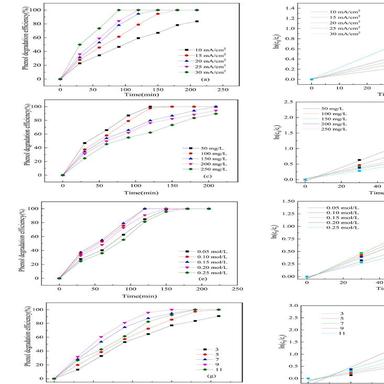
and d) presented the effect of different phenol concentrations (50, 100, 150, 200, 250 mg L− 1 ) on the degradation efficiency. With phenol concentration increasing, negatively affecting the degradation rate of phenol was significantly enhanced. The reaction process follows the first-order kinetic model, and the reaction rate constant value (k) decreased with the initial concentration increasing from 50 to 250 mg L− 1 . After 120 min, it could be completely degraded at 50 mg L− 1 phenol. But the removal of